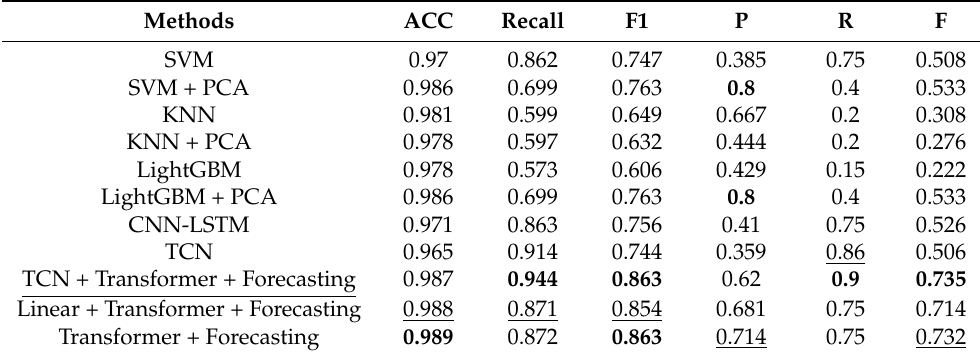
Table 5. Baselines experiment